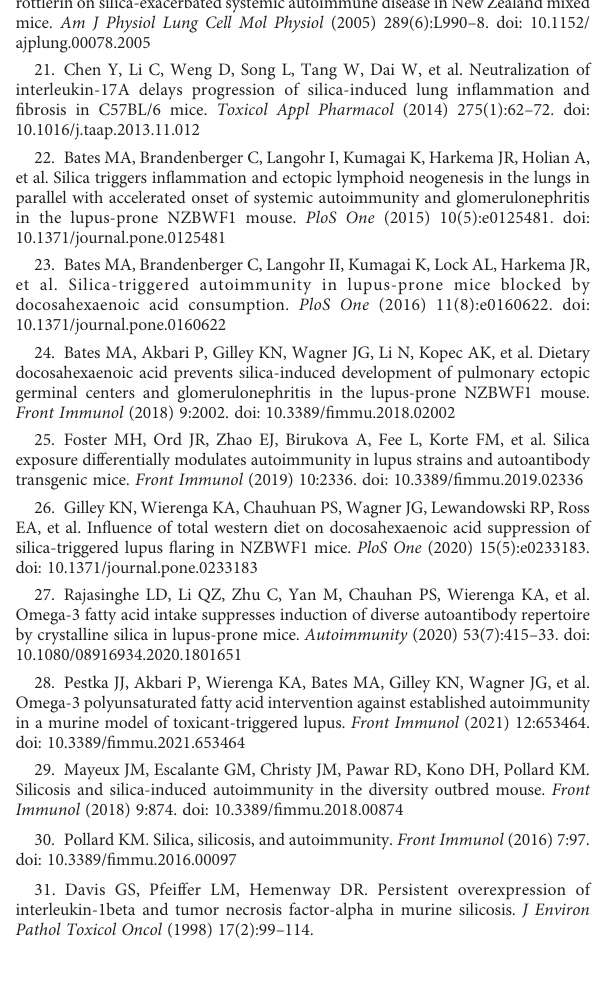
without intraperitoneal (i.p.) TLR4 ligand. Mice were exposed by oropharyngeal aspiration (OPA) at 2 or 3 months before tissue harvest, with or without i.p. injection of TLR4 ligand lipopolysaccharide (LPS) at 2 days prior to harvest. (A) Leukocyte count in BALF. (B) Number of ectopic lymphoid aggregates per whole lung section, quanti fi ed on FFPE lung sections stained with fl uorescently-labeled anti-B220 (B cells) and anti- CD3 (T cells) antibodies. (C, D) Autoantibodies measured in samples in duplicate using (C) undiluted BALF and (D) serum diluted 1/100 for anti- DNA Ig and 1/20 for anti-myeloperoxidase (MPO) Ig. Each circle represents an individual mouse; the bar indicates the mean for